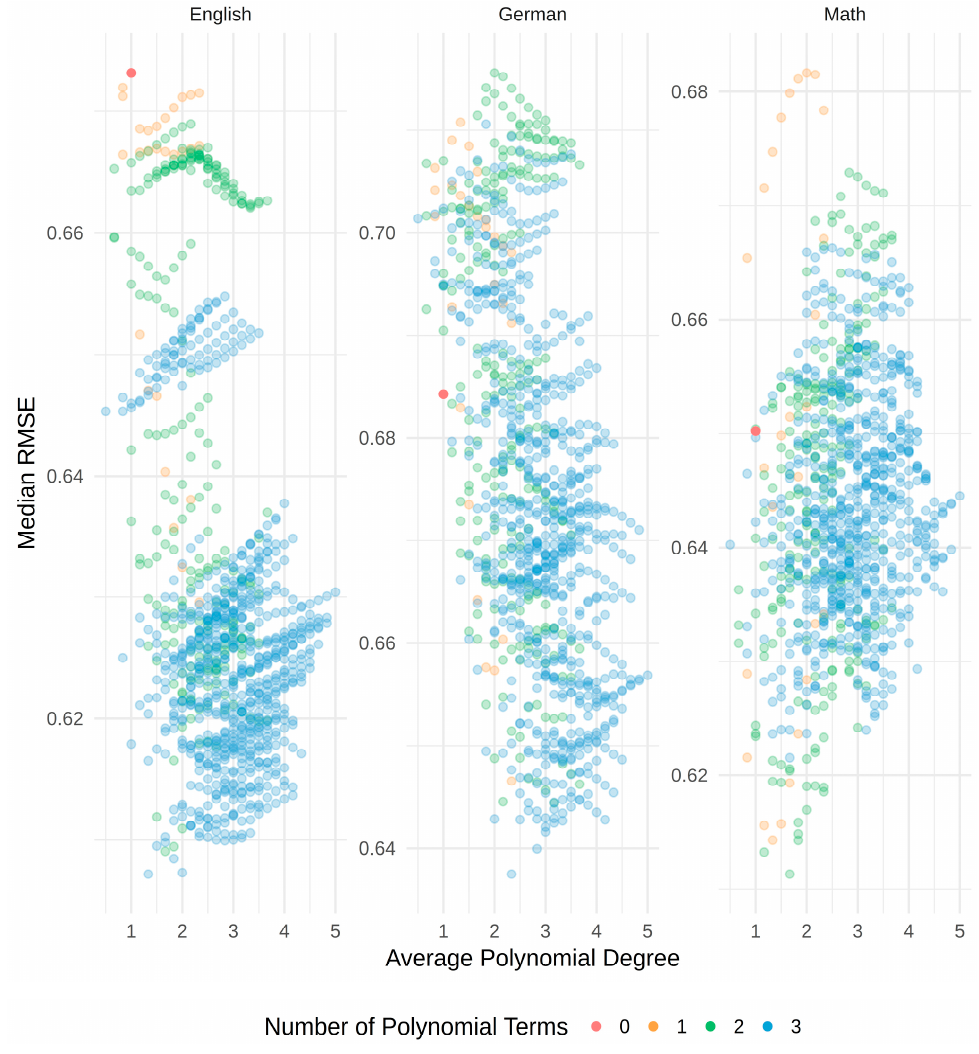
Figure 3. RMSEs for all models. The x -axis lists the average of the polynomial degrees (e.g., Unfoldingˆ2, Analogiesˆ3, NumberSeriesˆ4 results in an x -value of [2 + 3 + 4]/3 = 3). The model with linear terms only is depicted in red. Table 4. Summaries of the best fitting linear and polynomial